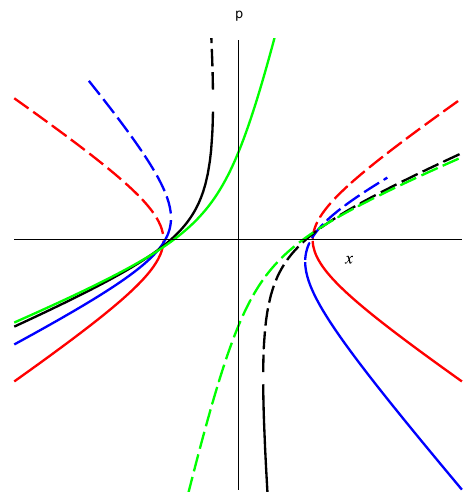
Figure 10. The fermi surface pro(cid:12)les for ! 0 > ! 1